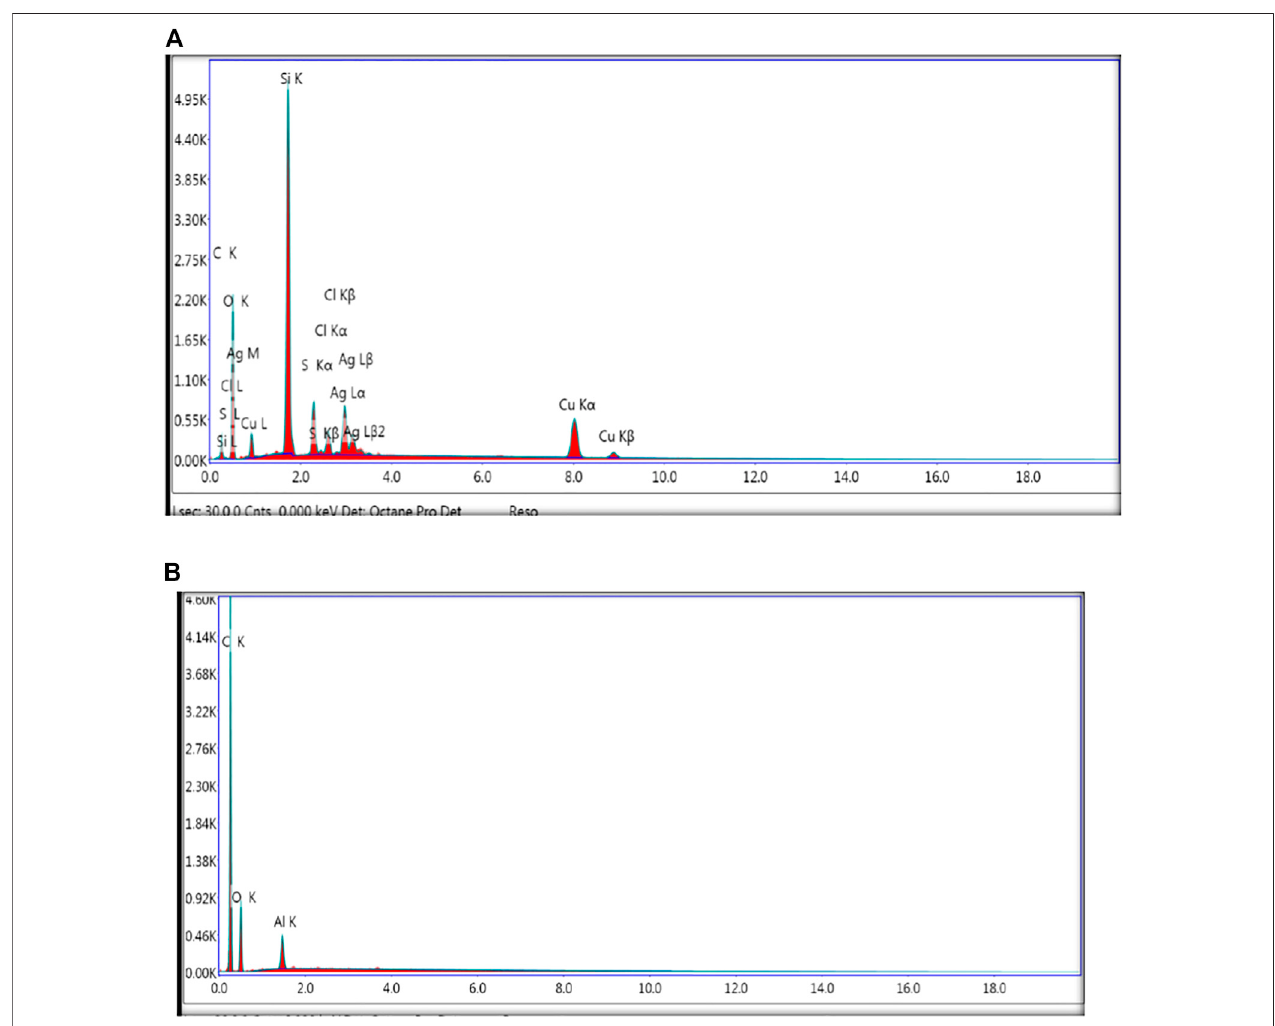
Frontiers in Materials |